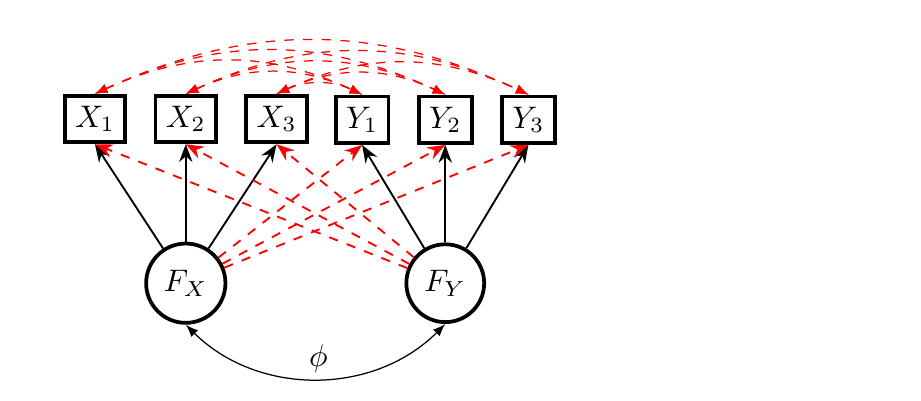
Figure 2. Two-factor CFA model: Data-generating model with local model misspecifications. Residual correlations are displayed with curved dashed red double arrows. Cross loadings are displayed with dashed red